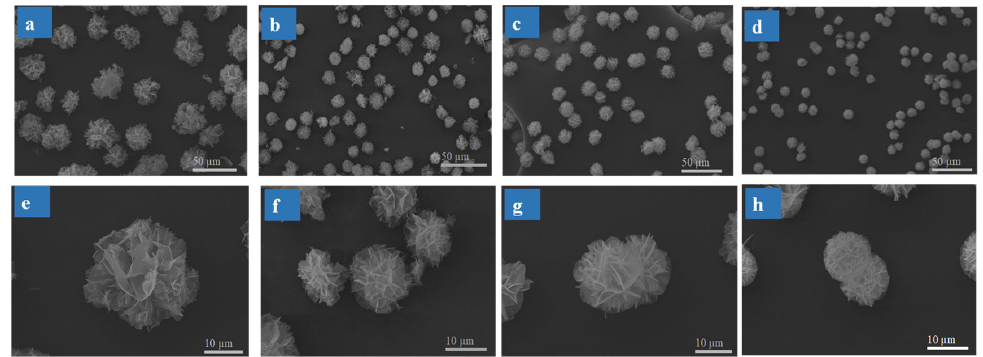
Figure 2. ( a – d ) SEM images of SF@Cu ‐ NFs with different SF concentrations at 50 mg L − 1 , 100 mg L − 1 , 200 mg L − 1 and 400 mg L − 1 , respectively. ( e – h ) The orresponding SEM images enlarged with mangnification of individual products.